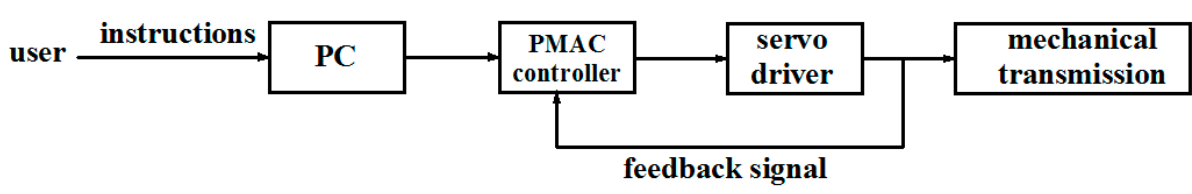
Figure 15. Frame diagram of experimental platform.